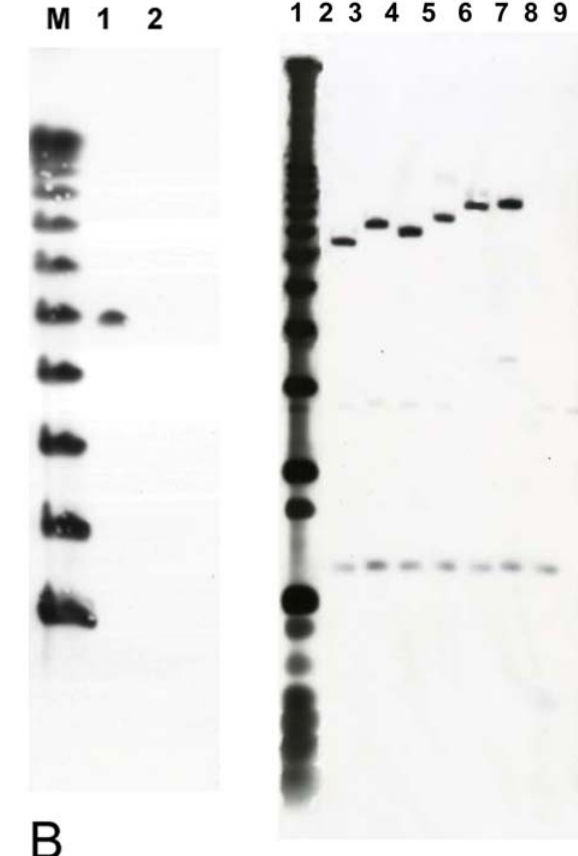
Figure 3. Restriction fragments lenghth polymorphisms (RFLP) obtained after hybridization of DNA ClaI restriction fragments of S.epidermidis isolates with a probe for arcCB from ACME. Lanes 1) and 10): 1 Kb plus DNA ladder; Lane 2): ClaI- arcCB pattern 1 (7 + 1.2 Kb); 3): ClaI- arcCB pattern 2 (7.5 + 1.2 Kb); 4): ClaI- arcCB pattern 3 (7.2 + 1.2 Kb); 5): ClaI- arcCB pattern 4 (8.0 + 1.2 Kb); 6): ClaI- arcCB